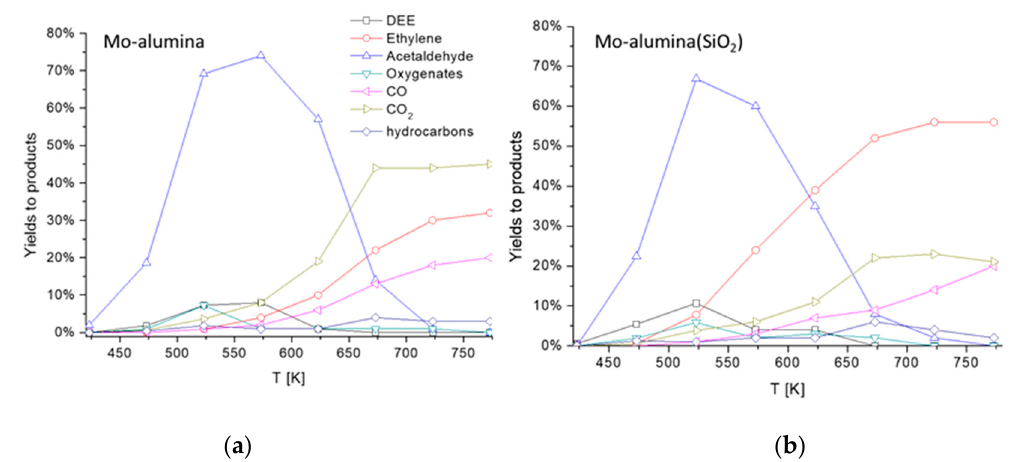
Figure 8. Results in the oxidative ethanol dehydrogenation over a ( a ) 12% MoO 3 /Al 2 O 3 and ( b ) 12% MoO 3 /Al 2 O 3 (5% SiO 2 ) catalyst. Yields to acetaldehyde, ethylene, ethyl ether and CO 2 . Experimental conditions: 2.1% C 2 H 6 O, 14.8% O 2 , 83.1% N 2 total flow 80 NmL/min, catalyst weight 0.5000 g.